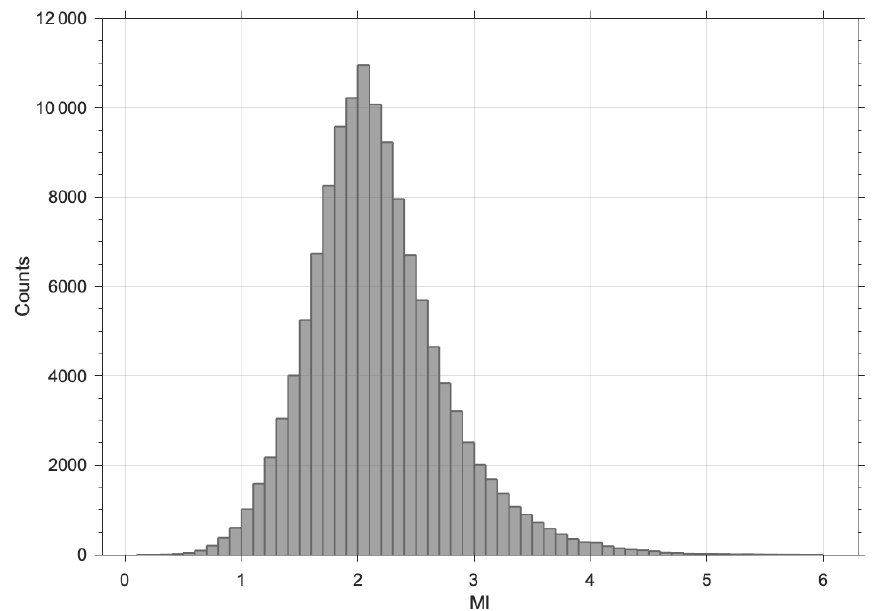
Figure 6. Earthquake – magnitude histogram of earthquakes with local magnitude, M l , in between the time interval 1 January 2012–31 De- cember